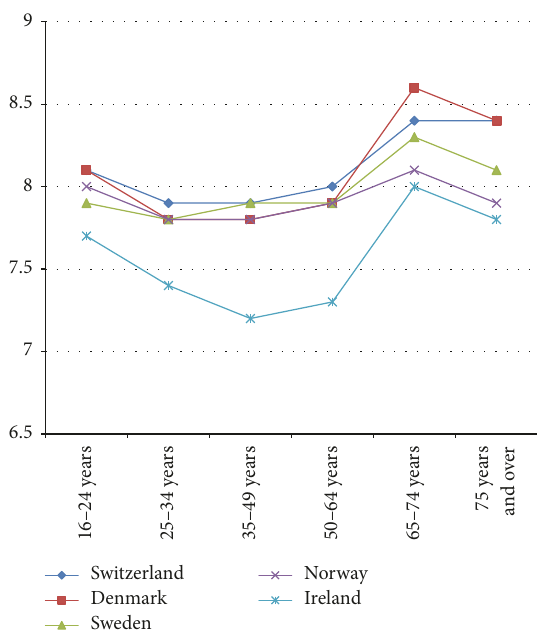
Figure 4: Relatively large U-shape in life satisfaction by age